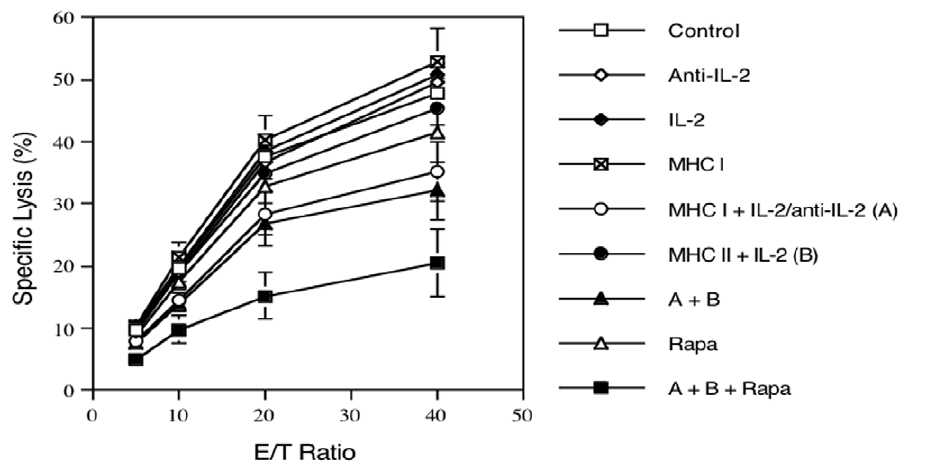
Figure 6. Donor-specific CTL activity of graft-infiltrating cells. One week after transplantation with Balb/C islets, graft-infiltrating cell were isolated from B6 recipient mice that were immunized with donor MHC DNA vaccines and/or treated with IL-2 regimen prior to transplantation, and analyzed for donor-specific CTL activity. MHC I + IL-2/anti-IL-2, but not MHC II + IL-2, treatments significantly suppressed CTL activity while the treatments with both plus rapamycin further reduced donor-specific CTL